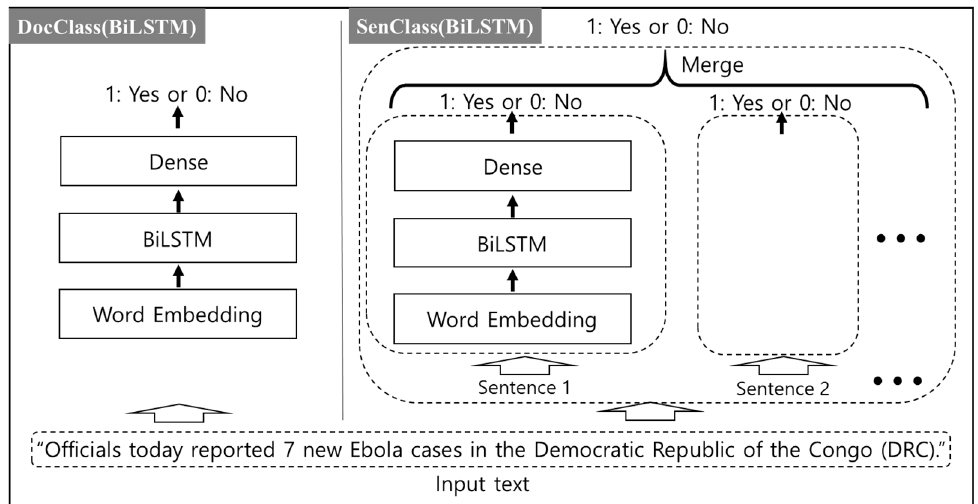
Figure 3. The BiLSTM model structure for two classification methods, DocClass and SenClass.